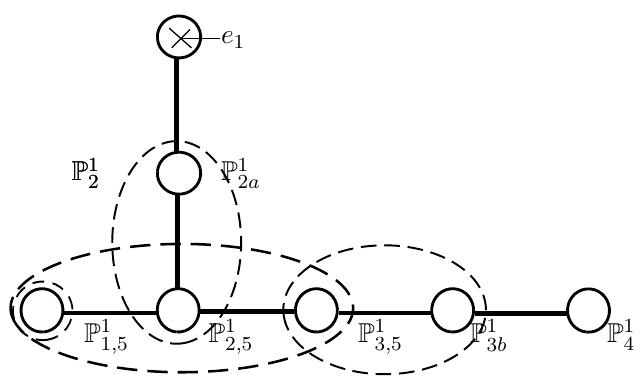
Figure 12 . P 1 intersection pattern at z Yukawa coupling 16 (cid:0)